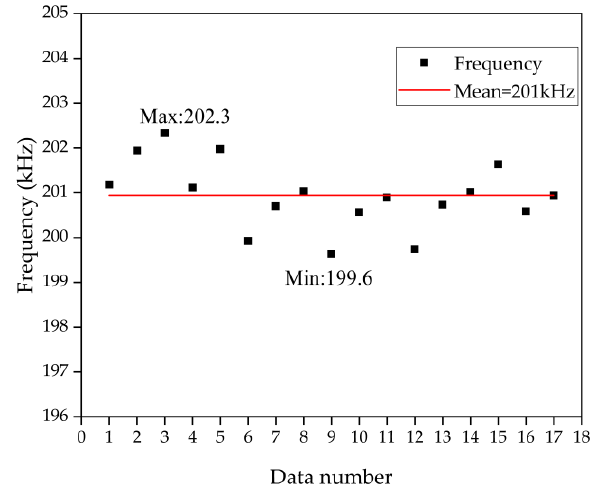
Figure 3. The frequency distribution of the PMUT array, the mean frequency is 201 kHz with a deviation of 1.5 kHz (the standard deviation is 0.732).